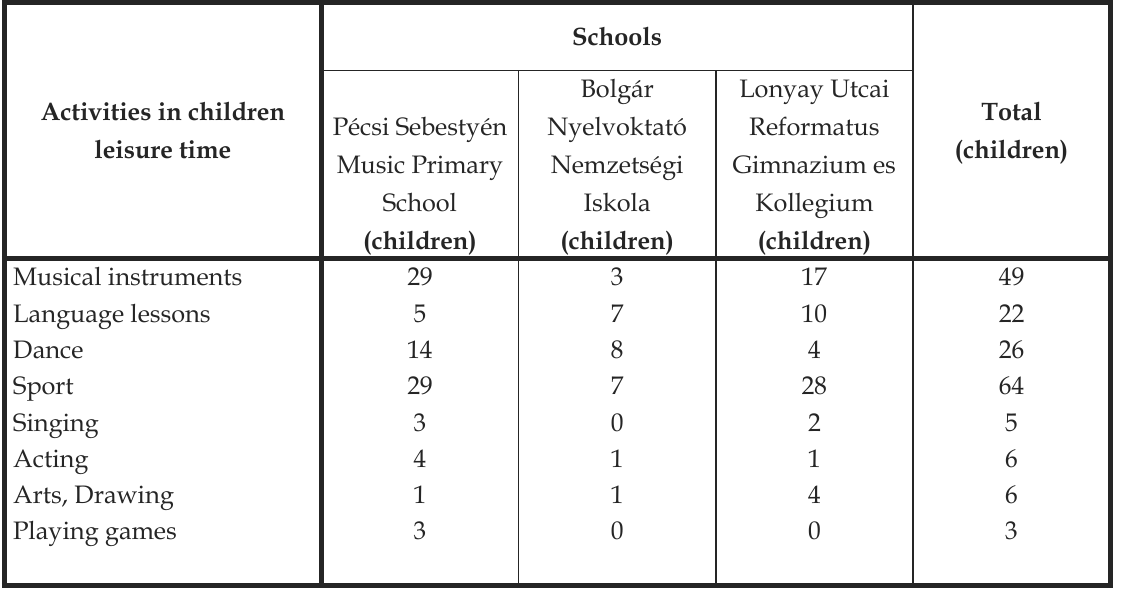
Table 2. Activities in children leisure time in